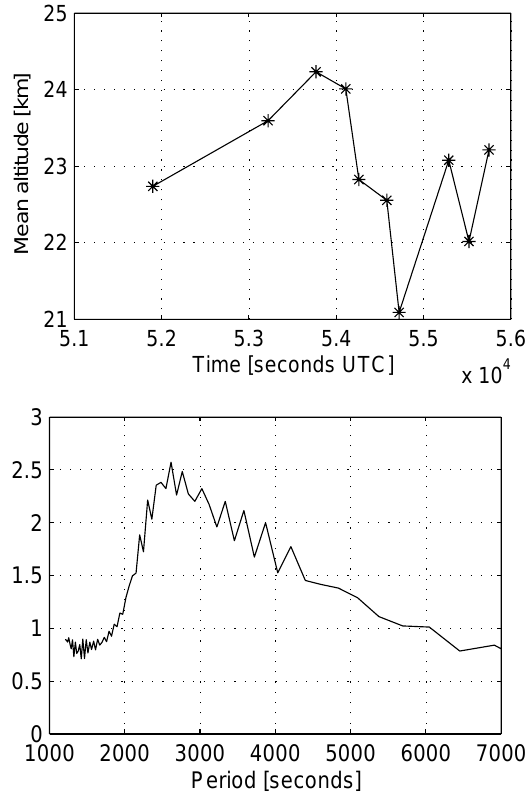
Fig. 13. ( a ) : The mean altitude vs. time of day (here shown in seconds) of the lines in Fig. 12, 14:10:00 UTC (51000s) to 15:33:20 UTC (56000s). ( b ) : Lomb-Scargle periodogram of the altitude